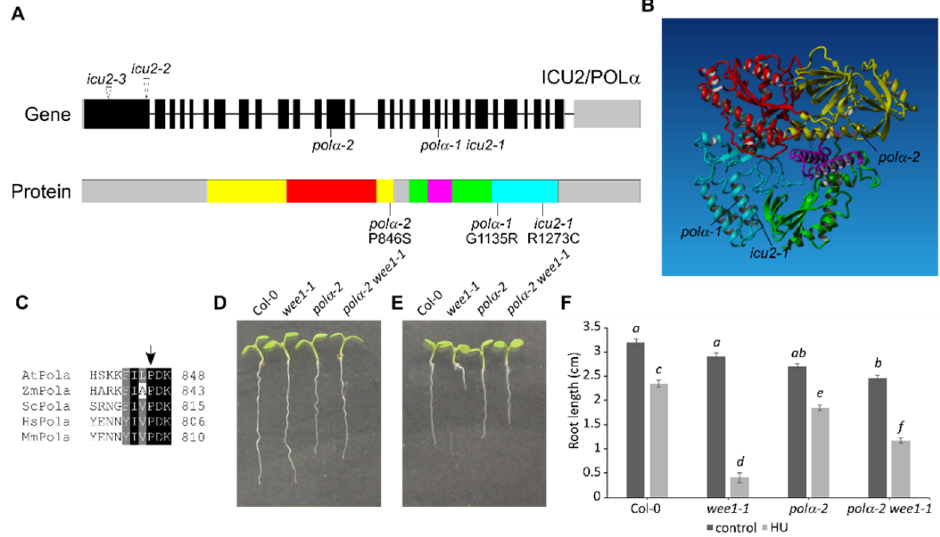
Figure 1. Characterization of the pol α -2 mutation. ( A ) Top, representation of the Arabidopsis ICU2/Pol α genomic locus and positions of all known mutant alleles. Bottom, representation of the protein domains and location of the known mutations. Yellow, N-terminal domain; red, exonuclease; green, palm; magenta, finger; cyan, thumb; grey, uncharacterized. ( B ) Model of the human polymerase α based on the structure of [24] with overlay of Arabidopsis mutated alleles. Colors are identical as in A. ( C ) Alignment of protein sequences of Arabidopsis , maize, yeast, human, and mouse polymerase α . Mutated position of pol α -2 is indicated by arrow. ( D ) and ( E ) Root growth of 7-day-old wild-type (Col-0), wee1-1 , pol α -2 , and pol α -2 wee1-1 seedlings grown on control medium ( D ) or medium supplemented with 0.75 mM HU ( E ). ( F ) Quantification of root growth shown in ( D ) and ( E ). Data represent the mean ± SEM (n > 10 in three biological repeats). Significance was tested with mixed model analysis. The means with different letters are significantly different ( p < 0.05).